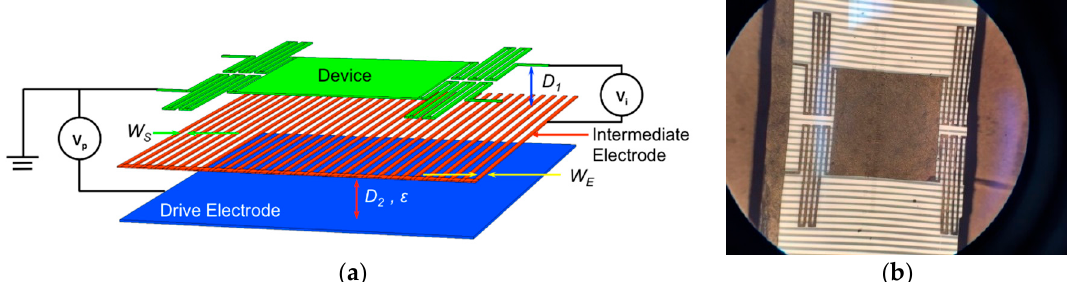
Figure 1. ( a ) Schematic of the tri-electrode prototype. ( b ) Fabricated structure under microscope.